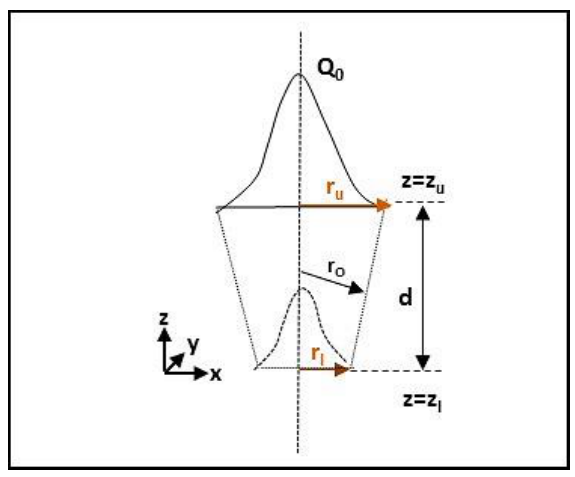
Figure 4. Conical heat source.